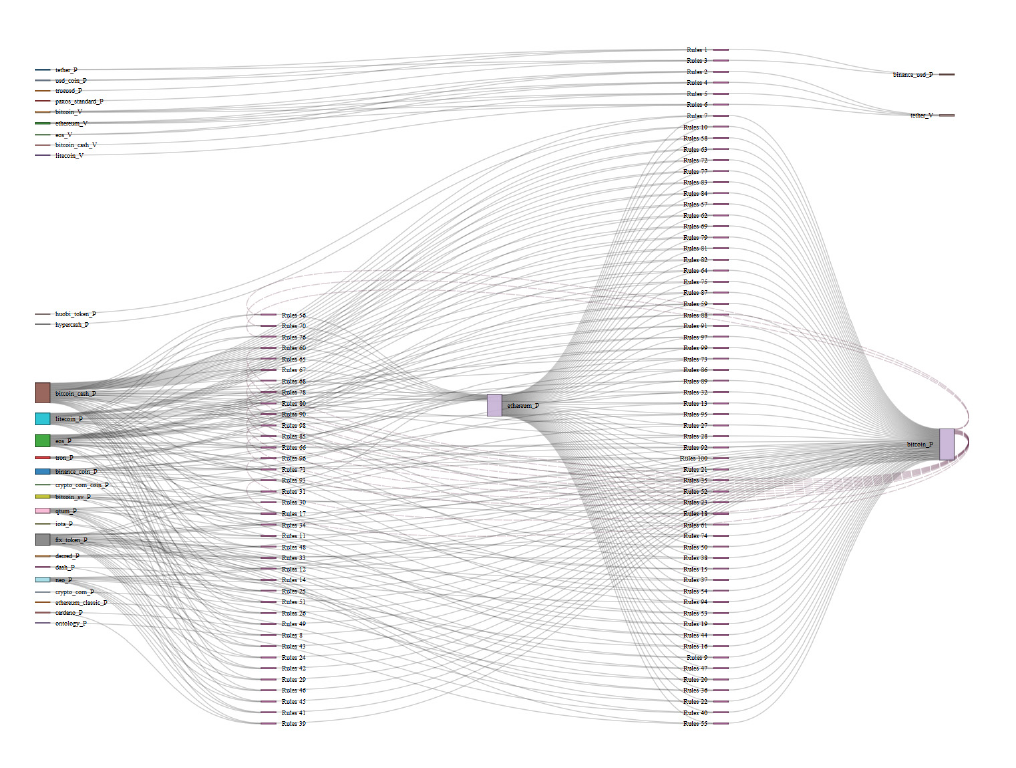
Figure 10. Sankey diagram that shows the direction from the antecedents (LHS) to the consequences (RHS) for the 100 rules of Subset